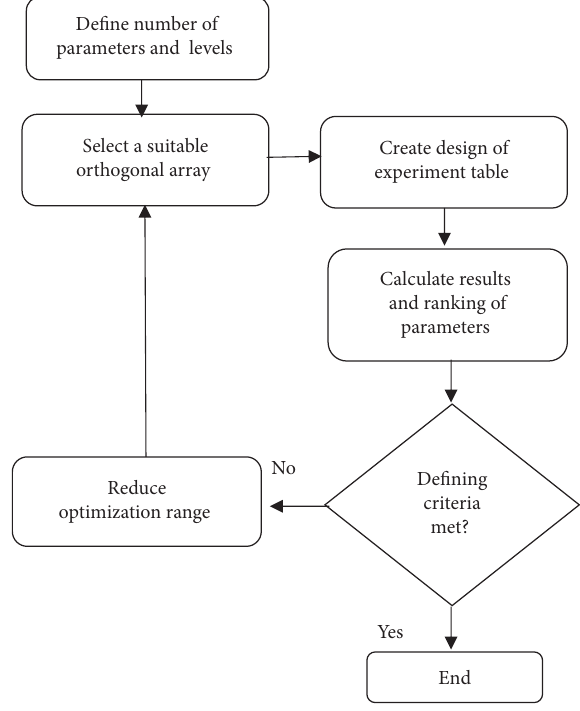
Figure 2: General Taguchi’s method approach Table 2: Taguchi orthogonal array selection matrix [23].